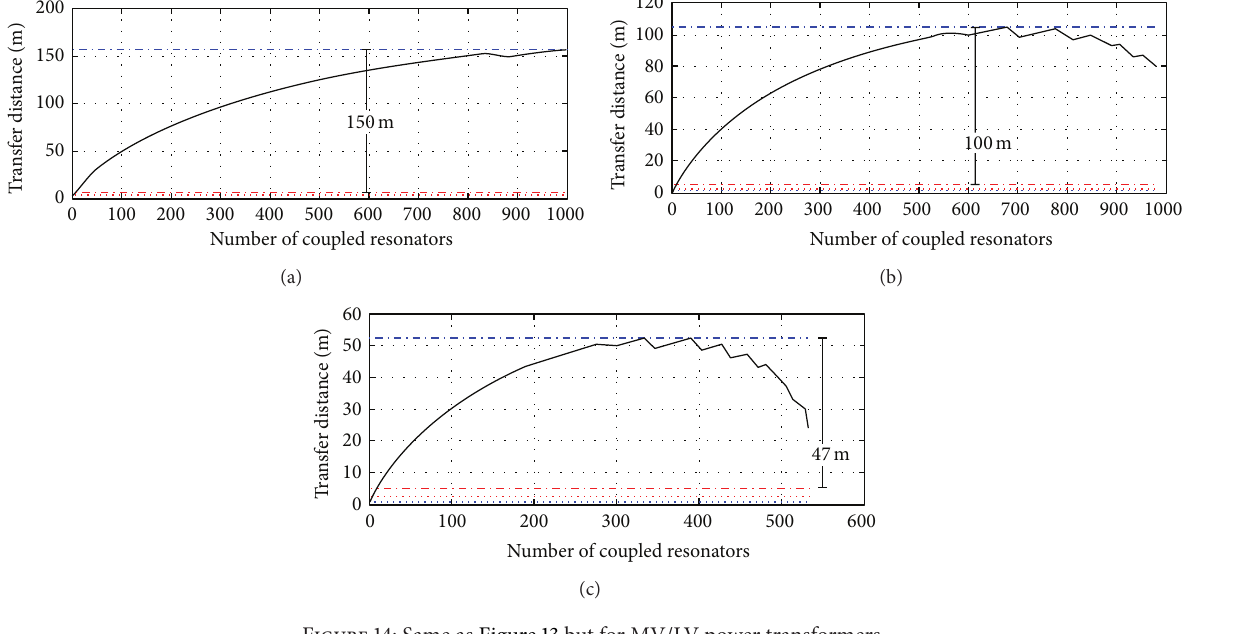
Figure 14: Same as Figure 13 but for MV/LV power